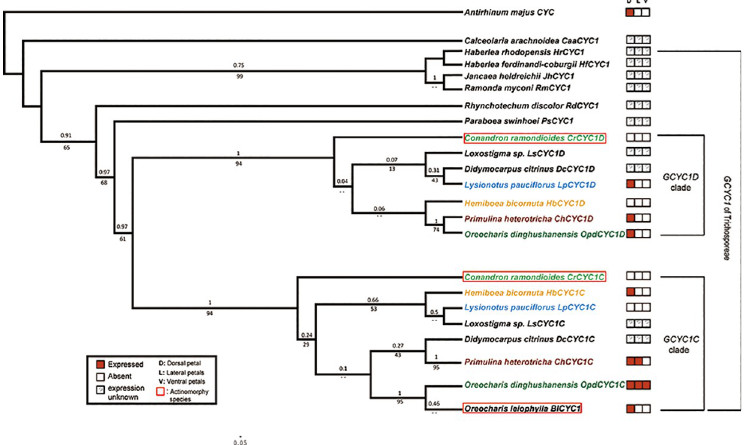
Fig 5. GCYC1 phylogenetic tree with summarized GCYC1C and GCYC1D expression pattern in tribe Trichosporeae species. BI cladogram based on GCYC1 sequences of species in tribe Trichosporeae. Numbers above branches and below branches are approximate likelihood and posterior probability values obtaining from ML and BI analyses respectively. GCYC1 expression patterns are shown in color by organ: D: dorsal petal, L: lateral petal, V: ventral petal; red squares represent presence and white squares absence of gene expression in the respective flower part; square with ‘?’ denote unknown expression. Expression pattern were compiled from this work and previous studies ([27, 28, 31]). GCYC genes isolated from actinomorphy species in boxes. Light green font: Conandron ramondioides , dark green font: Oreocharis dinghushanensis , light blue font: Lysionotus pauciflorus , Orange font: Hemiboea bicornuta , Brown font: Primulina heterotricha , Black font: Oreocharis leiophylla .